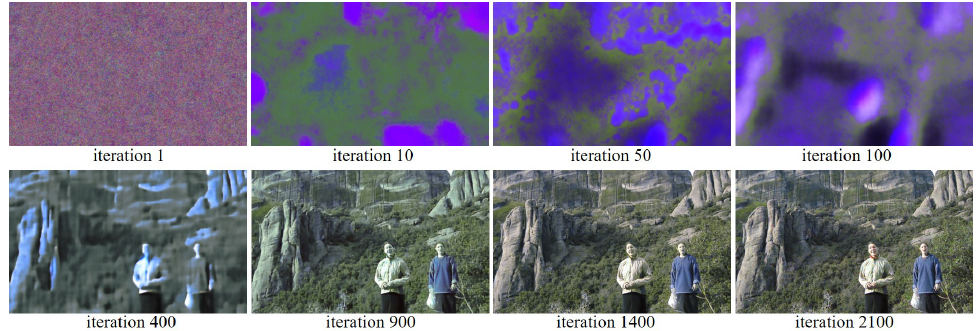
Figure 6. Showing the process of reconstructing the Kodak No. 25 image as the iteration progresses. To show the effectiveness of using the same ratio R, G, and B pixels as opposed